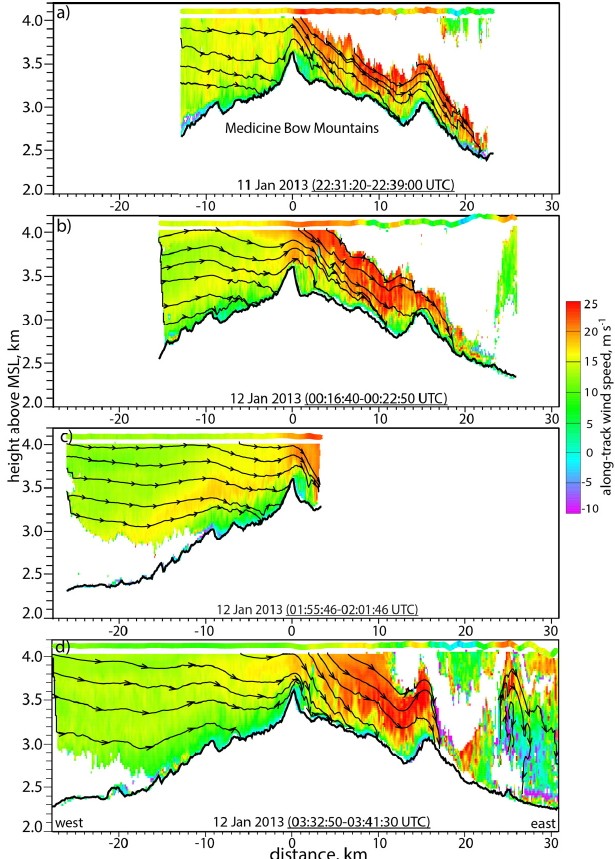
Figure 12. As in Figure 8, but for along-track (zonal) wind speed and hydrometeor streamlines, derived from WCR dual-Doppler synthesis. The gust probe zonal wind speed is shown at flight